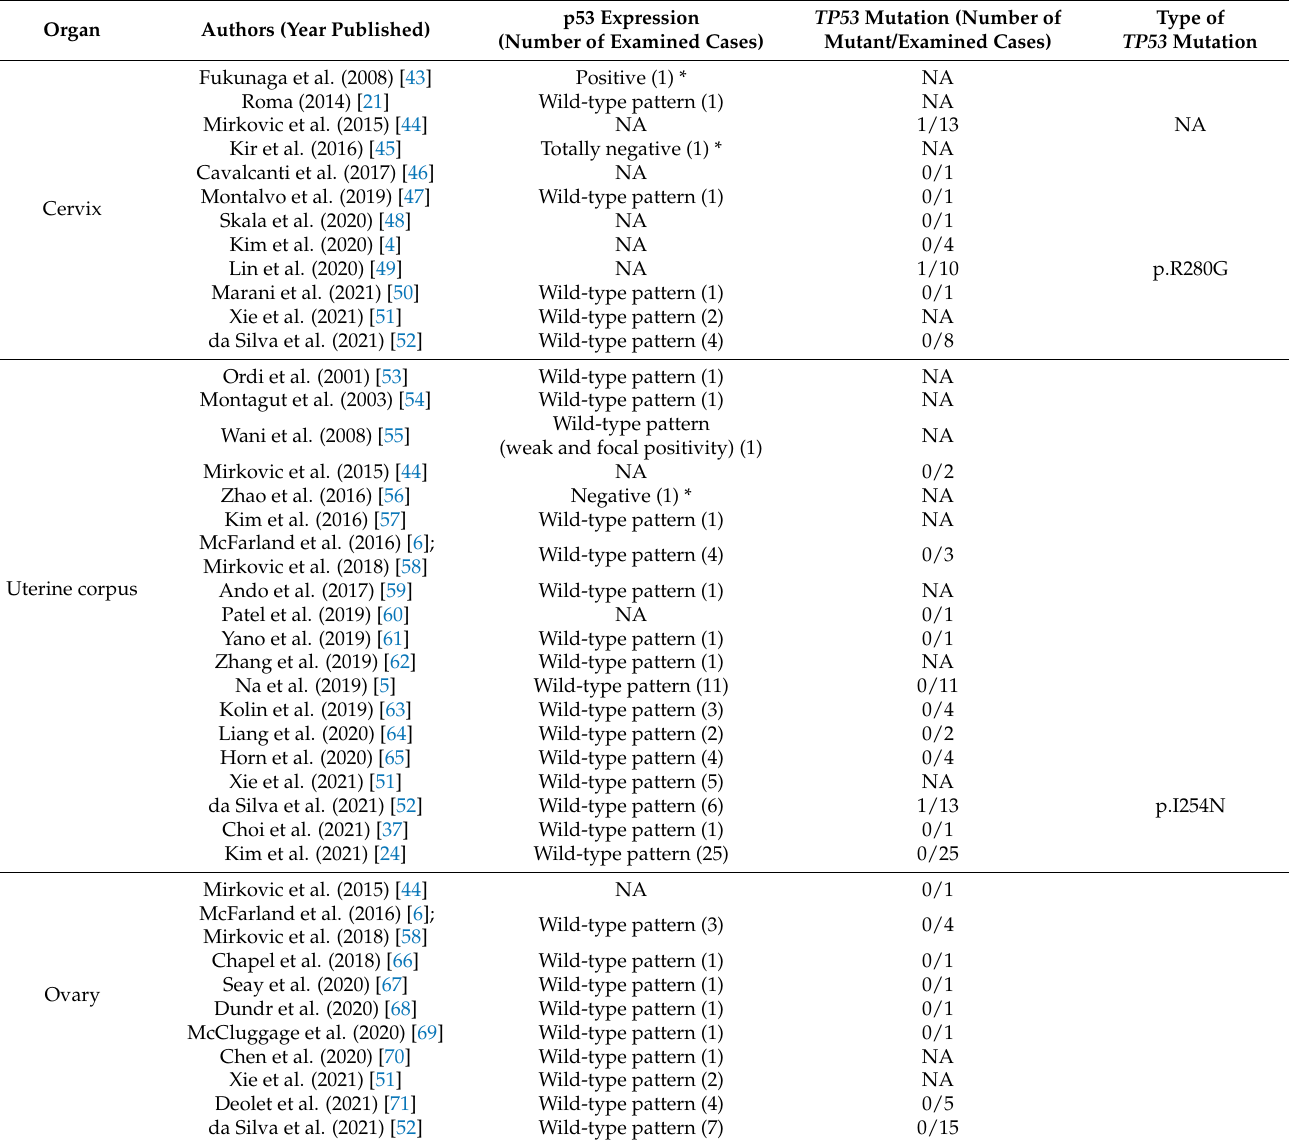
Table 4. p53 expression and TP53 mutation of cervical mesonephric and uterine/ovarian mesonephric- like